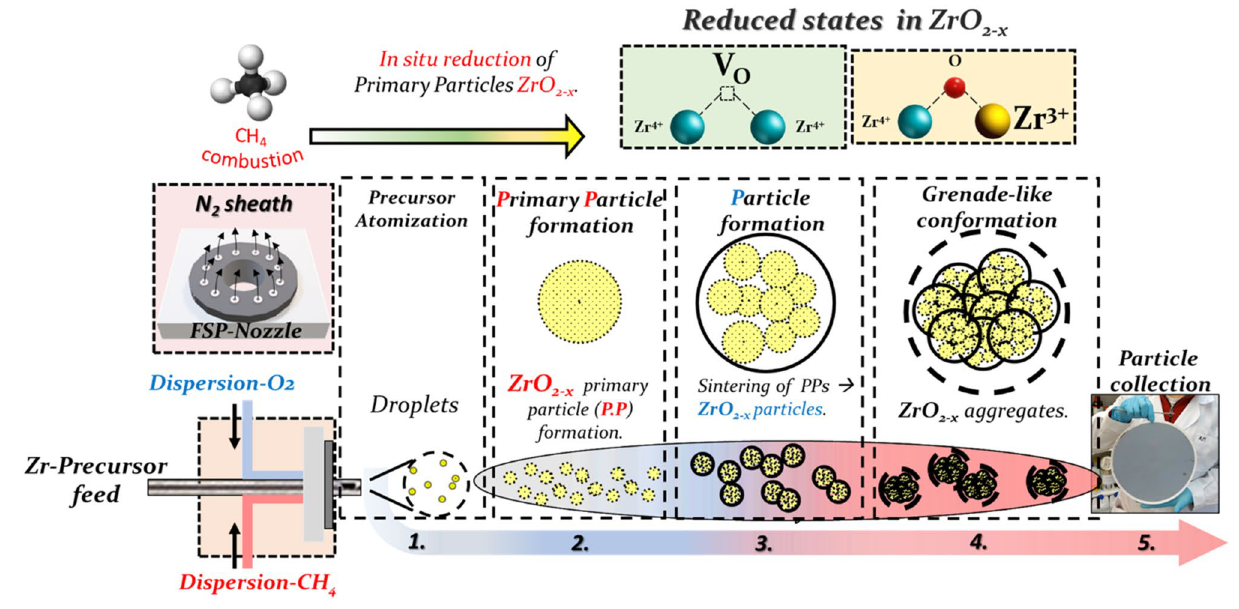
Figure 1. One-step FSP process for ZrO 2−x production. The photo at right shows as-produced 500 mg of [1.3/1.7] ZrO